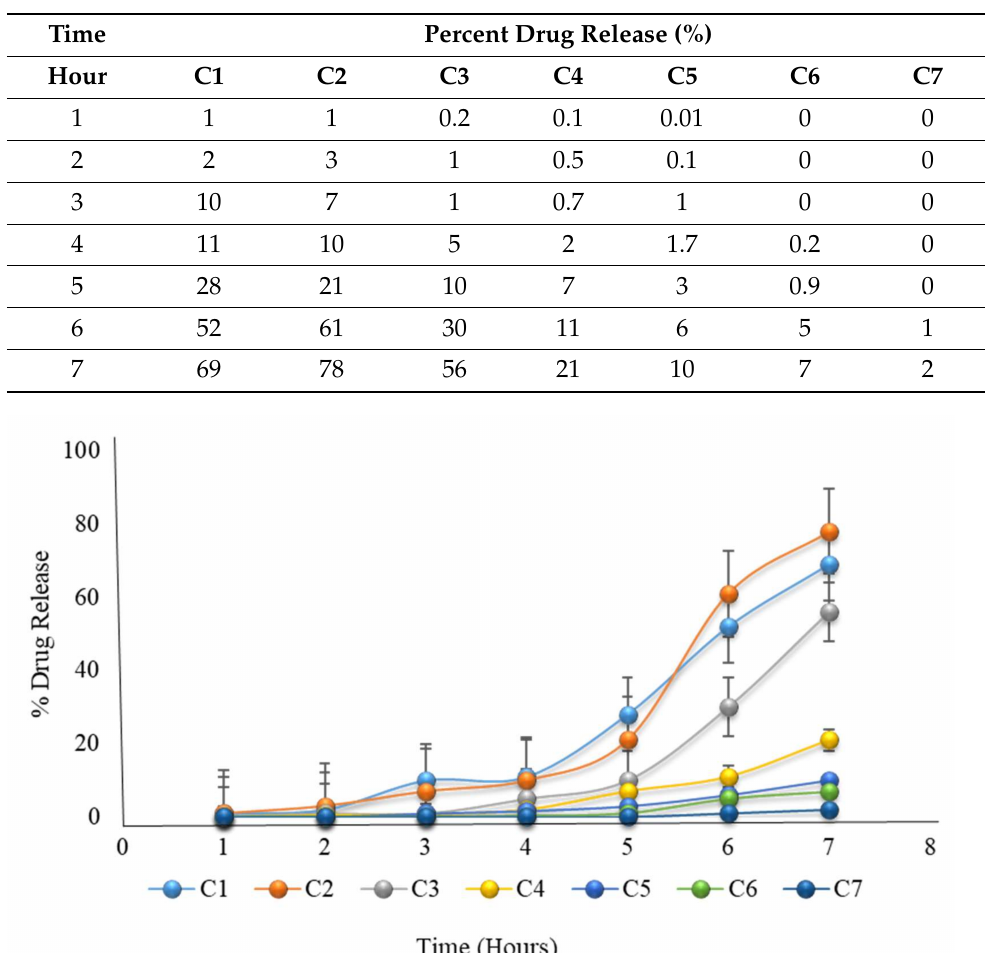
Table 7. The in vitro dissolution of formulations C1 to C7 (the first 2 h in an acid medium of pH 1.2, and then in a phosphate buffer medium of pH 6.8).